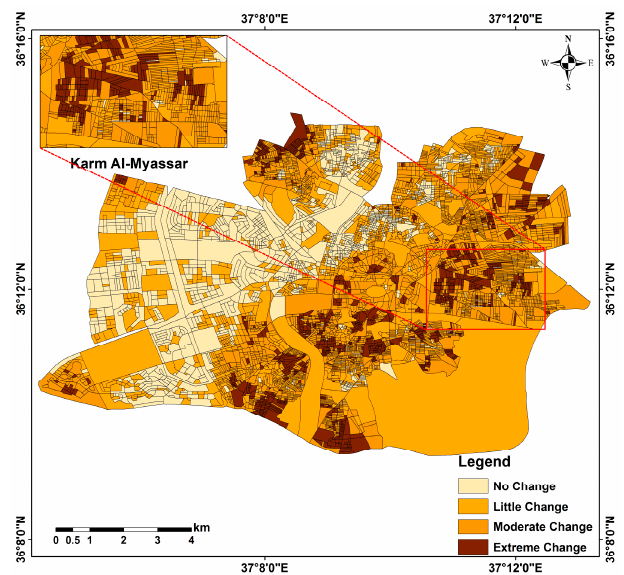
Figure 17. Aleppo standard deviation map shows higher standard deviation on street blocks in the eastern side.